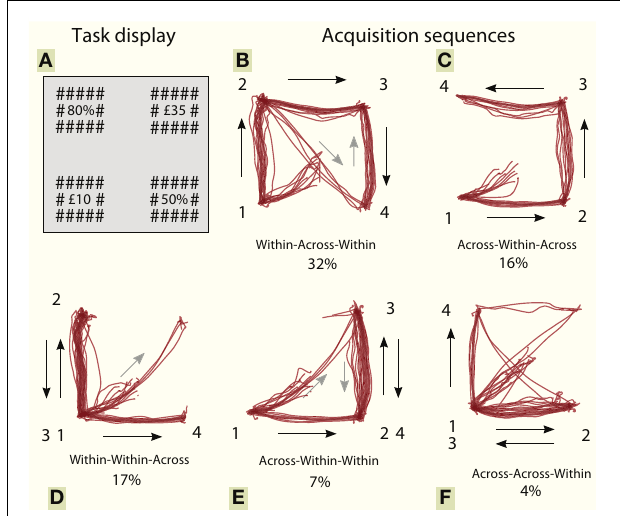
FIGURE 2 | (A) Our task is a choice between two gambles, presented on the left and right hand sides of the screen. Participants freely viewed a display with four numbers, to acquire information about the two gambles. Without a time limit, they selected the preferred gamble by a keypress. Each gamble had a probability of winning vs. losing, denoted with a “%” suffix, and a monetary stake, denoted with a “£” prefix. After selection, a sound indicating win/lose was played over a loudspeaker, and the bank balance was displayed centrally. The numbers were small and were presented close to isoluminance, ensuring that fixation was necessary to identify numbers. (B–F) Example scan paths of the first four acquisitions from one participant, aligned so that the first saccade is to the lower left. Trajectories are classified according to the fixation pattern: each of the three saccades could either be within an option or across options. Numbers represent order of acquisition.